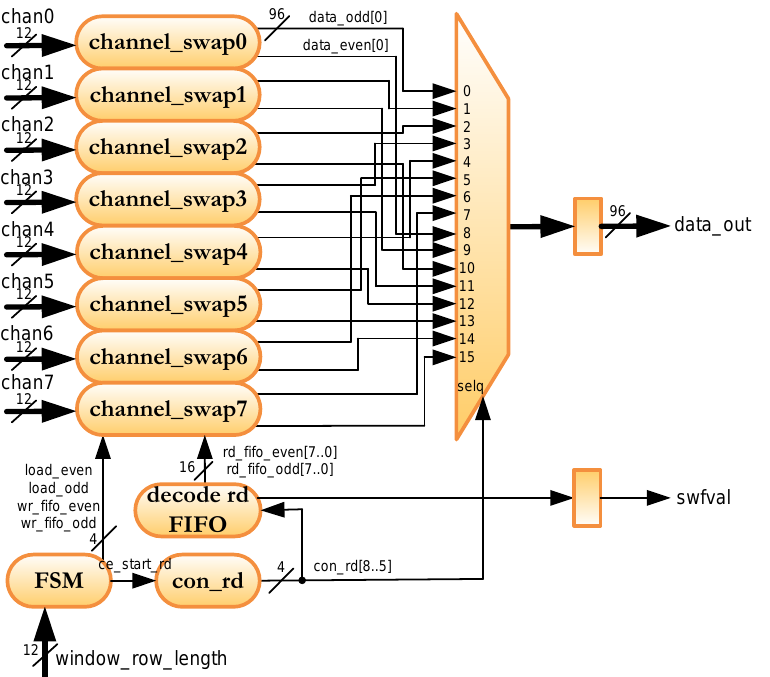
Figure 8. Block diagram of the implemented swapping.vhd module.